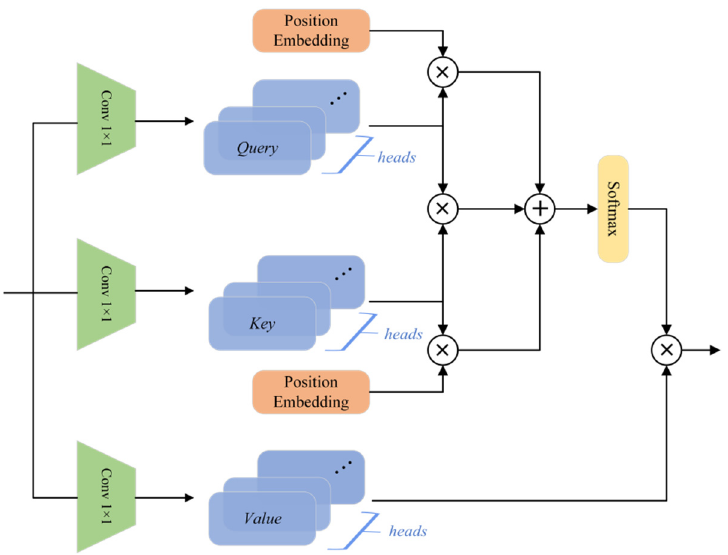
Figure 4. The architecture of the MHSA layer. We use relative position embedding in Transformer encoder. Conv1×1 is used to change the dimension of the matrix and increase the nonlinearity of the feature map.